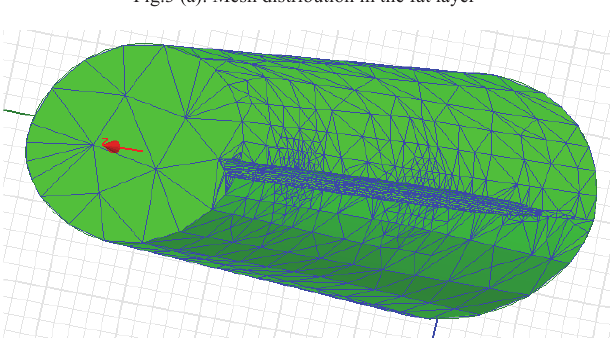
Fig.3 (a): Mesh distribution in the fat layer